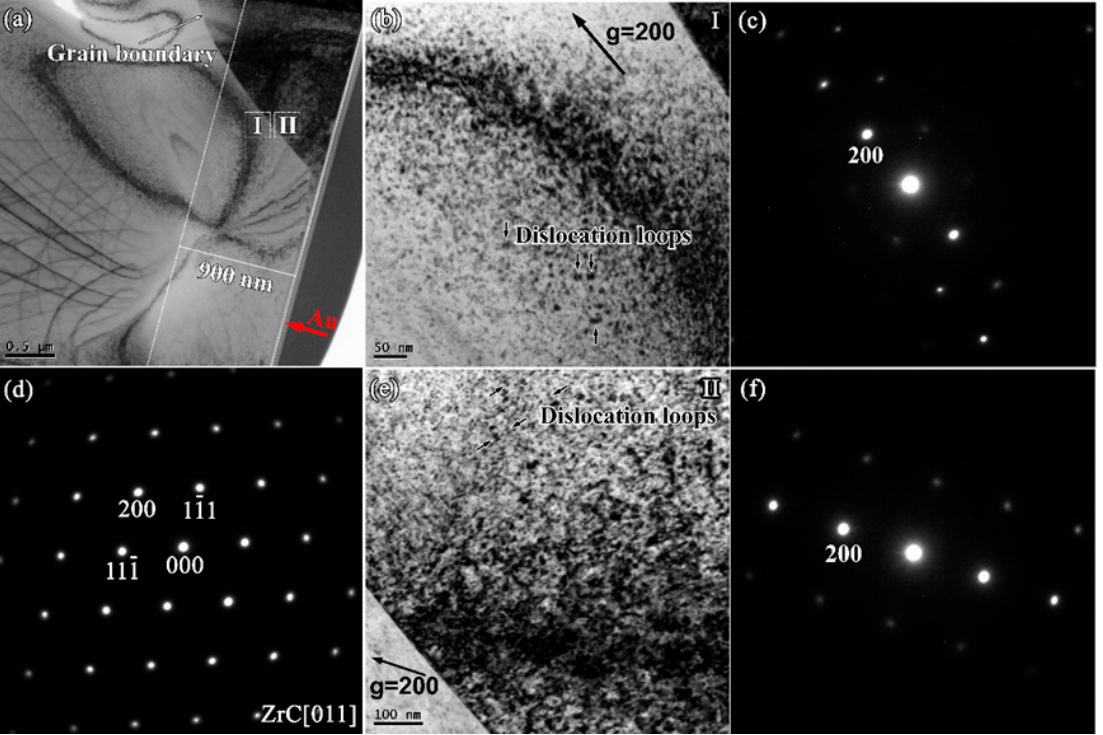
Figure 5. ( a ) Cross-section bright field (BF)-TEM images of ZrC after irradiation; ( b ) BF image of irradiated ZrC at region I taken from ( c ) a two-beam condition diffraction pattern with g = 200 near zone axis [011]; ( d ) Selected area electron diffraction (SAED) patterns obtained from the zone axis [011] of the damaged area; ( e ) BF image of irradiated ZrC at region II taken from ( f ) a two-beam condition diffraction pattern with g = 200 near the zone axis [001].